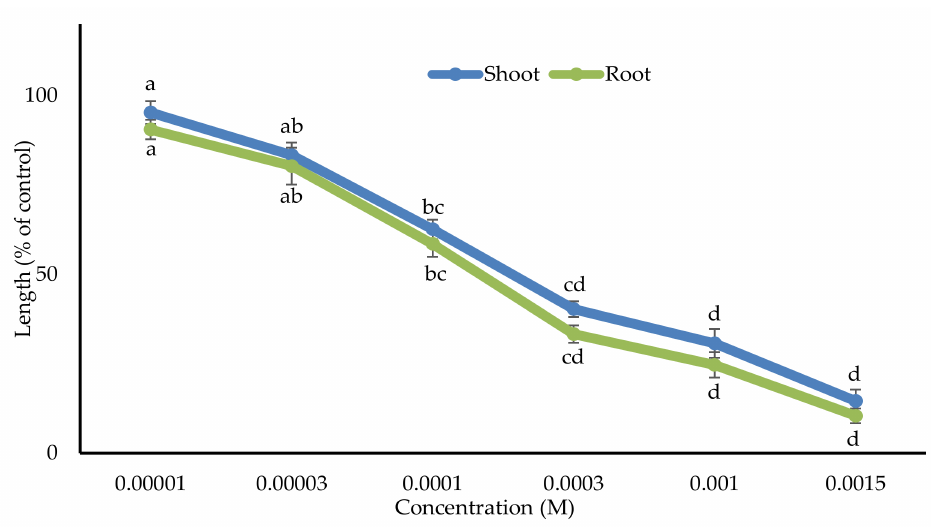
Figure 3. The phytotoxicity of compound (3 R )-3-hydroxy- β -ionone against cress. Values indicate means ± SE from three replications ( n = 30). Significant variations between control and treatment are indicated by various letters ( p < 0.05–0.001).